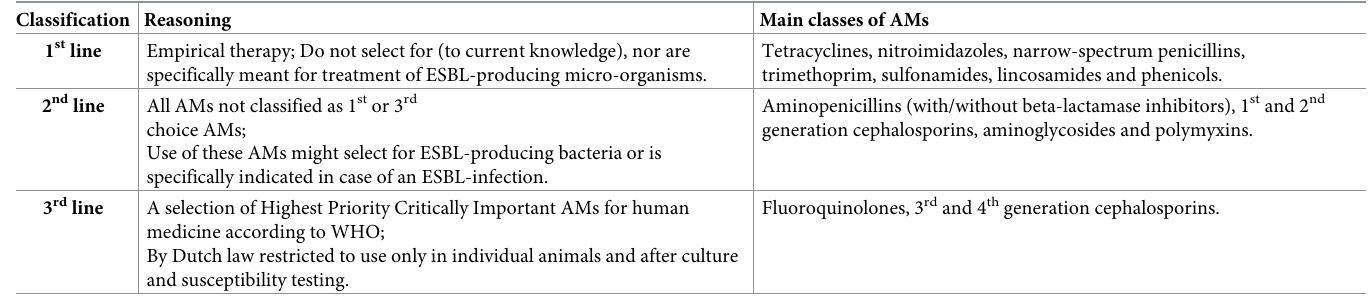
Table 1. Classification of veterinary AMU according to Dutch policy on veterinary AMU